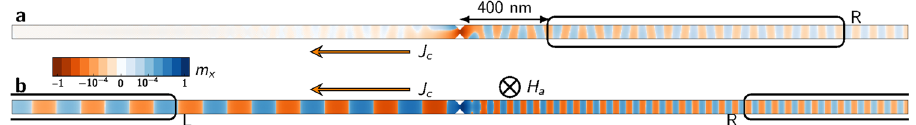
Figure 2. Snapshot of the magnetization dynamics representing the = m M M / value. ( a) A current density of x x s . × − 6 5 10 Am 10 2 is injected. The region R on the right where m x is sampled is enclosed by a rectangle. Unidirectional SW propagation towards the right can be observed. ( b) Snapshot of the magnetization dynamics under the concurrent action of an in-plane current of × − 24 10 Am 10 2 and an external field of 300 mT directed inside the plane to oppose DW depinning. A wire twice as long as in ( a) is considered. Emission of SWs is observed both towards the right and the left at different frequencies and wavelengths; the sampled regions on the left ( L ) and right ( R ) are enclosed by black rectangles, and they extend for 2 μ